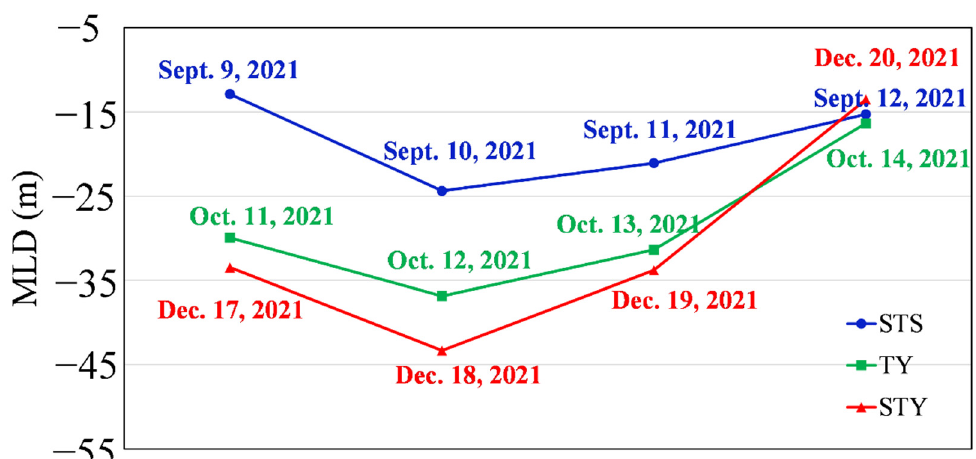
Figure 12. The MLD before and after the passage of STS “Conson”, TY “Kompasu” and STY “Rai”. Before the passing of STS (9 September 2021), during the STS (10 September 2021), after the passing of STS (11–12 September 2021). Before the passing of TY (11 October 2021), during the TY (12 October 2021), after the passing of TY (13–14 October 2021). Before the passing of STY (17 December 2021), during the STY (18 December 2021), after the passing of STY (19–20 December